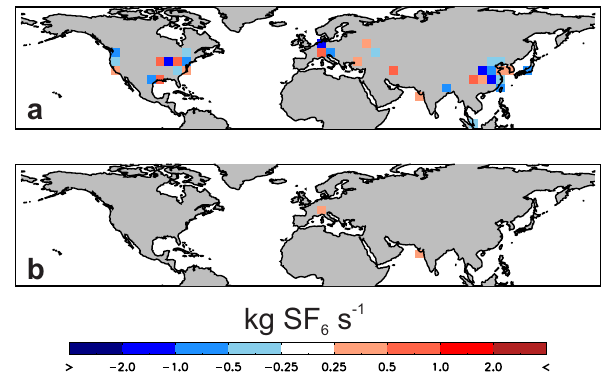
Fig. 9. (a) A priori flux error ( kggridcell − 1 s − 1 ) for INVICAT experiment using pseudo-observations, defined as x b − x tr , where x b is the a priori flux estimate and is created by randomly perturbating the “true” fluxes, x tr consistently with the error statistics of the a priori. (b) A posteriori flux error for the same experiment after 10 minimisation iterations, defined as x 10 − x tr .